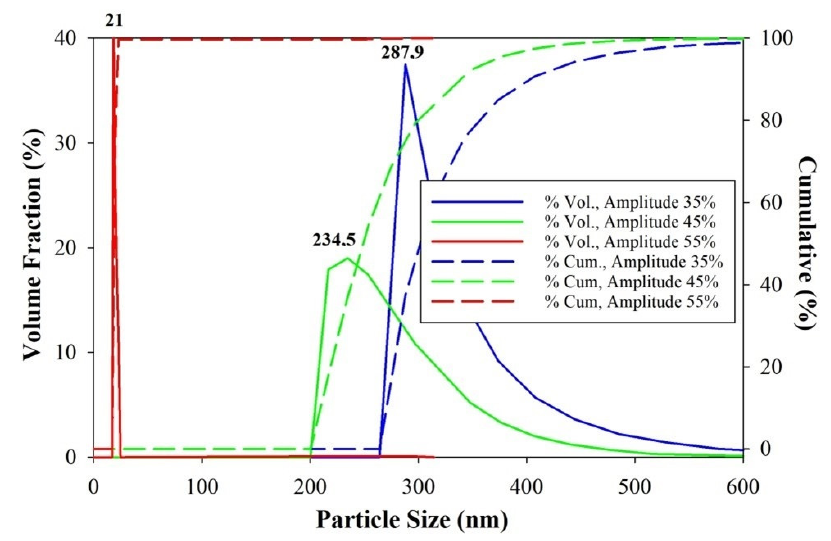
Figure 12. Effect of amplitude on particle size distribution of BaFe 11.2 Mg 0.4 Al 0.4 O 19 . Transducer and amplitude have a linear relationship in producing cavitation bubbles